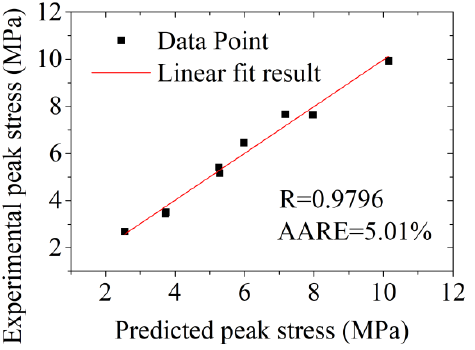
Figure 9. Relationship between the experimental and calculated peak stress of the cold radial forged 6063 aluminum alloy processed by SSIC.